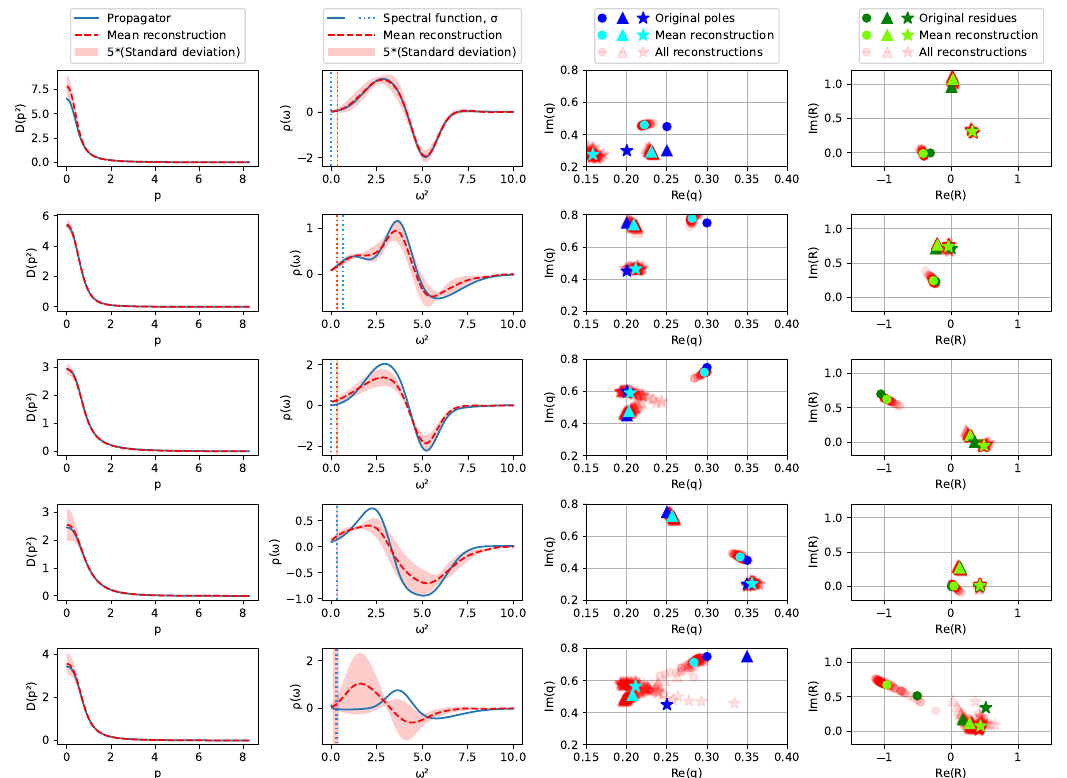
Figure 3: The robustness to noise of the five propagators from the previous